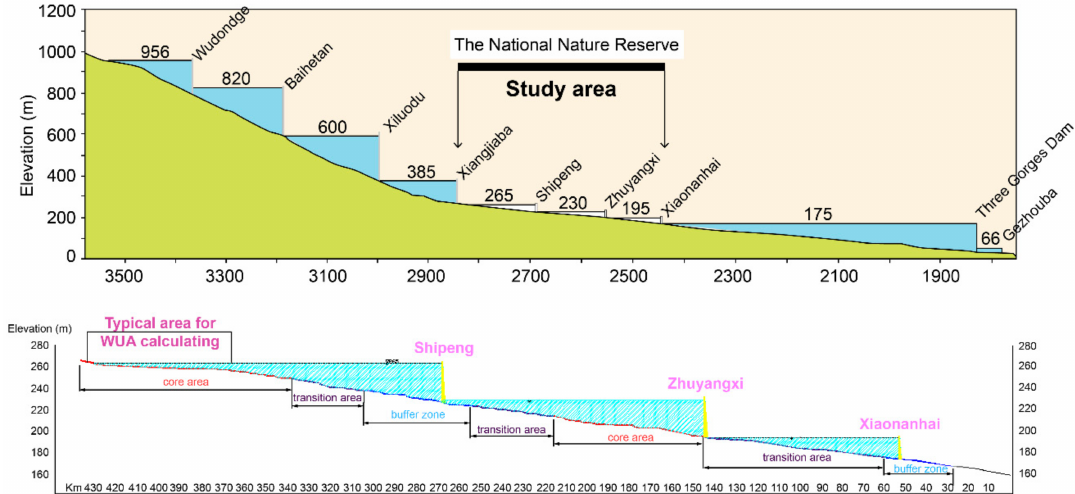
Figure 2. Sketch map showing the study area between the dams of Shipeng, Zhuyangxi, and Xiaonanhai, which have been